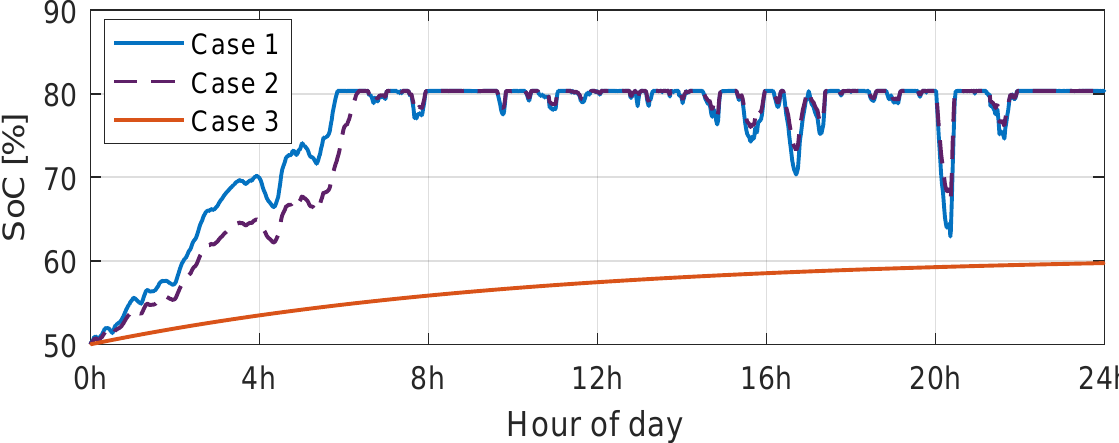
Figure 26. Scenario 1: state-of-charge ( SoC ) signals with Case 1: λ 1 = 100, λ 2 = 0, Case 2: λ 1 = λ 2 = 50, and Case 3: λ 1 = 0, λ 2 = 100. Initial SoC: 50% and P SCHED with maximum ± 30% error.